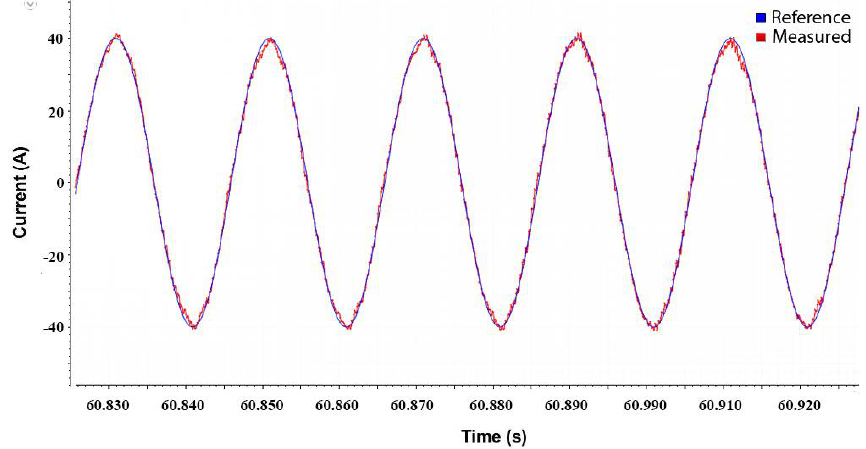
Figure 13. DSPACE-1202 front panel, Phase-A reference current at 20A.